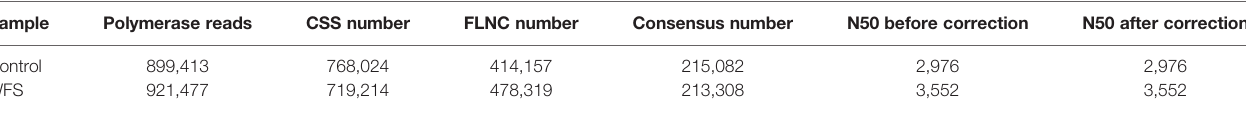
TABLE 2 | Sequencing information of full-length transcriptome.